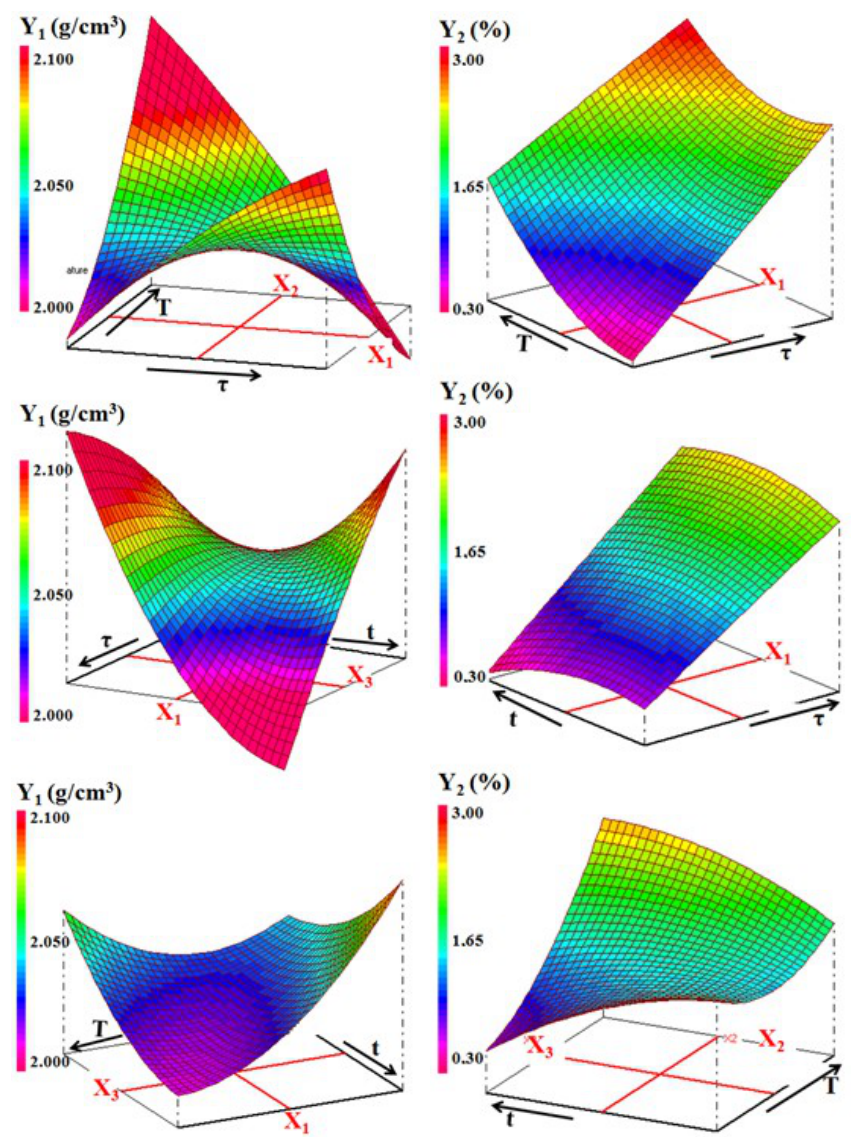
Figure 14. Three-dimensional representation of the variations of density ( Y 1 ) and the firing shrinkage Figure 13. Three-dimensional representation of the variations of density (Y 1 ) and the firing shrinkage ( Y 2 ) against the processing factors for the ternary (Y 2 ) against the processing factors for the ternary mixture.